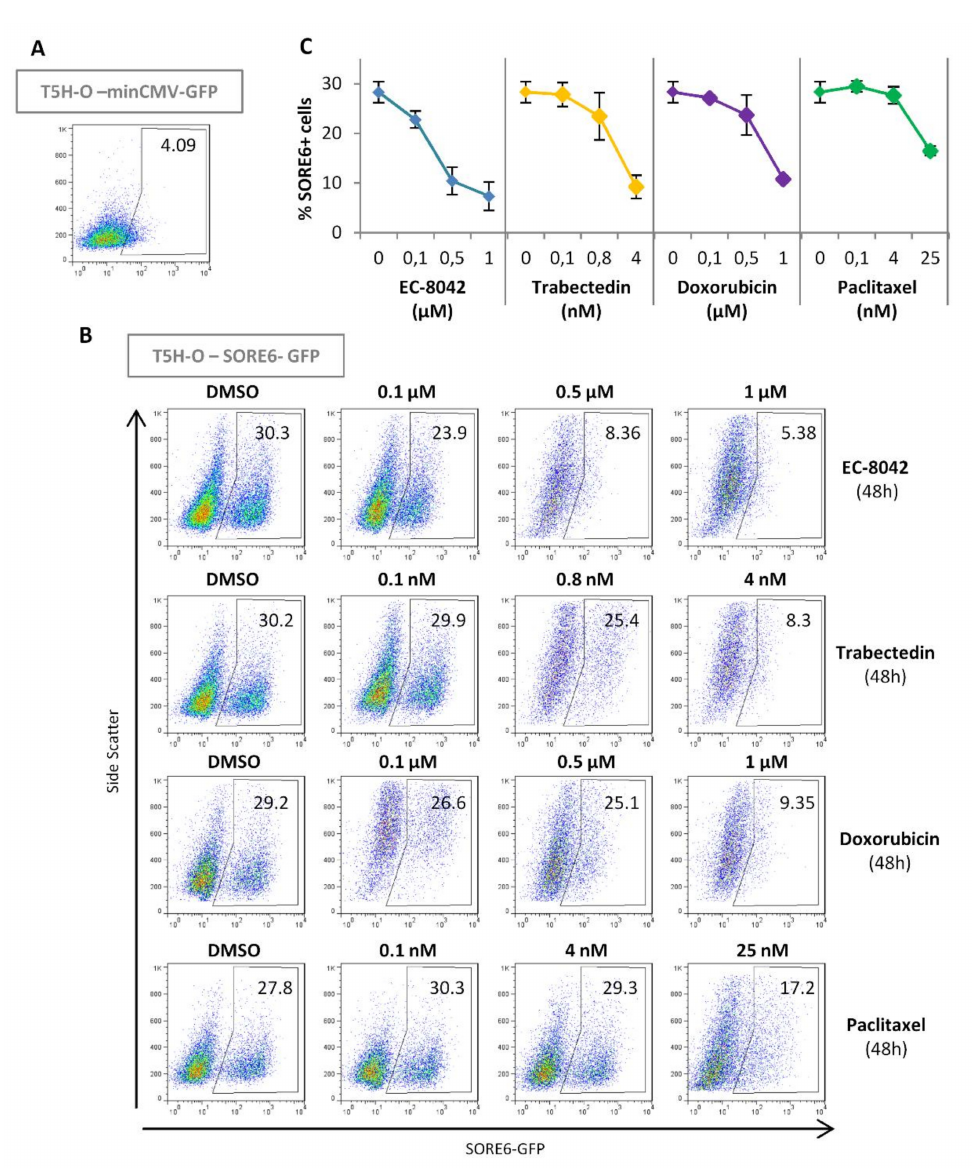
Figure 5. Dose-response e ff ect of anti-tumor drugs on SORE6 positive CSCs. ( A , B ) Representative flow cytometry analysis of SORE6 + population in untreated T5H-O-minCMV-GFP (gating control) ( A ) or in T5H-O-SORE6-GFP cells treated with the indicated concentrations of EC-8042, trabectedin, doxorubicin or paclitaxel for 48 h ( B ). ( C ) Graph showing the mean ± standard deviation of three independent